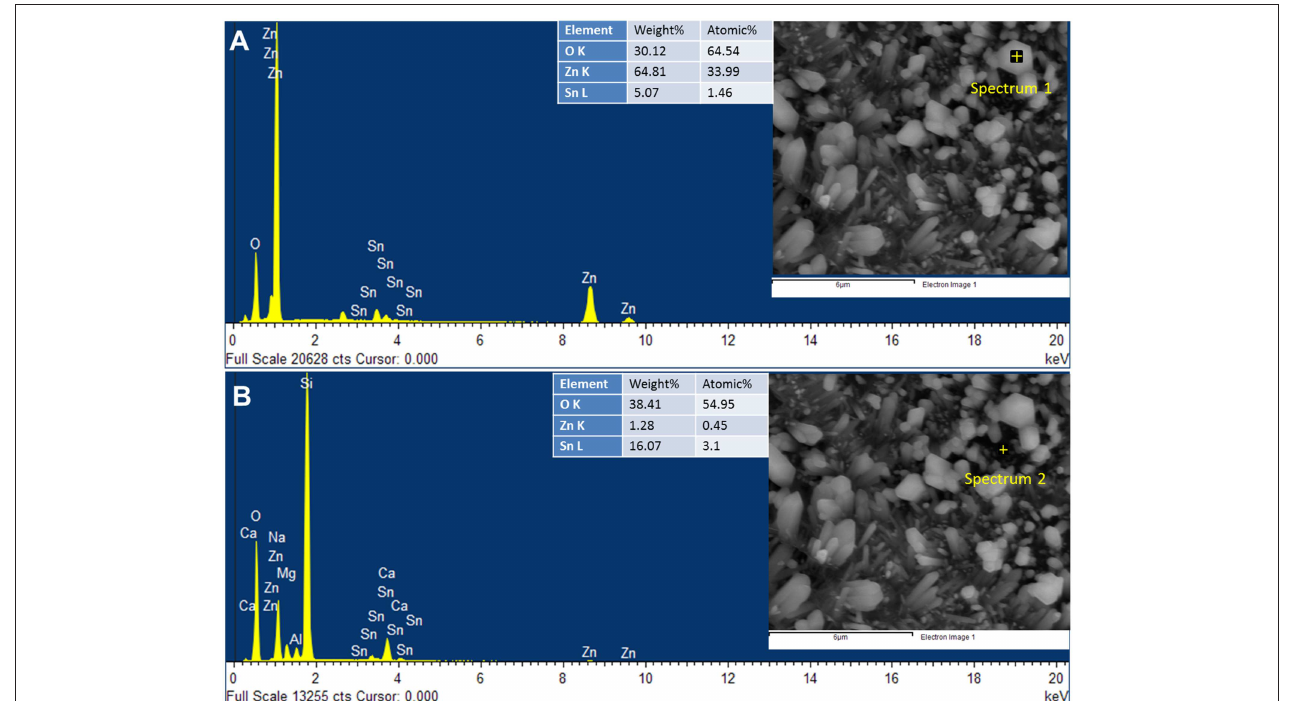
FIGURE 3 | The EDX spectra obtained at two different positions: (A) on the ZnO nanorod and (B) on the surface of the 15Z5S film.